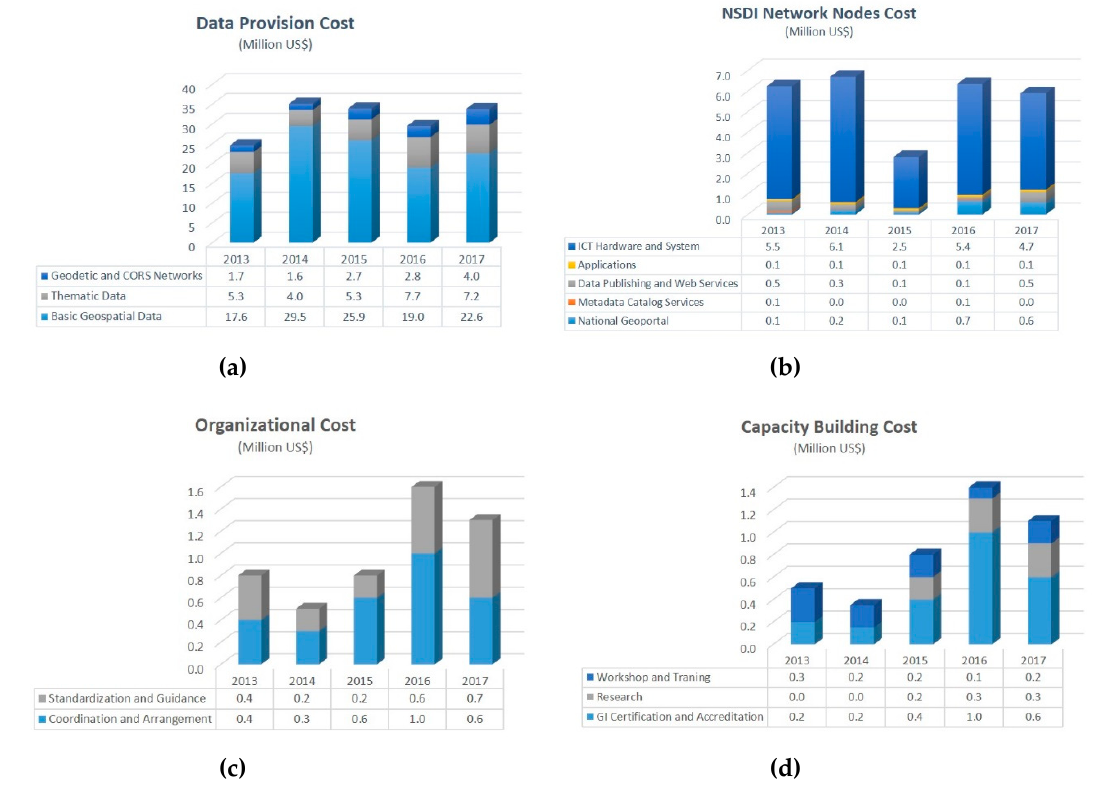
Figure 11. Four national spatial data infrastructure (NSDI) development costs in detail: (a) Data provision; (b) NSDI network nodes; (c) Organizational; (d) Capacity